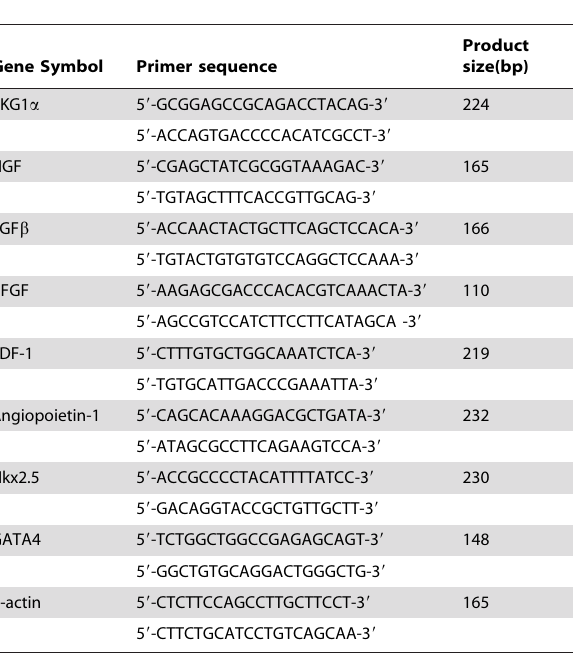
Table 1. Sequence of the primers used in the